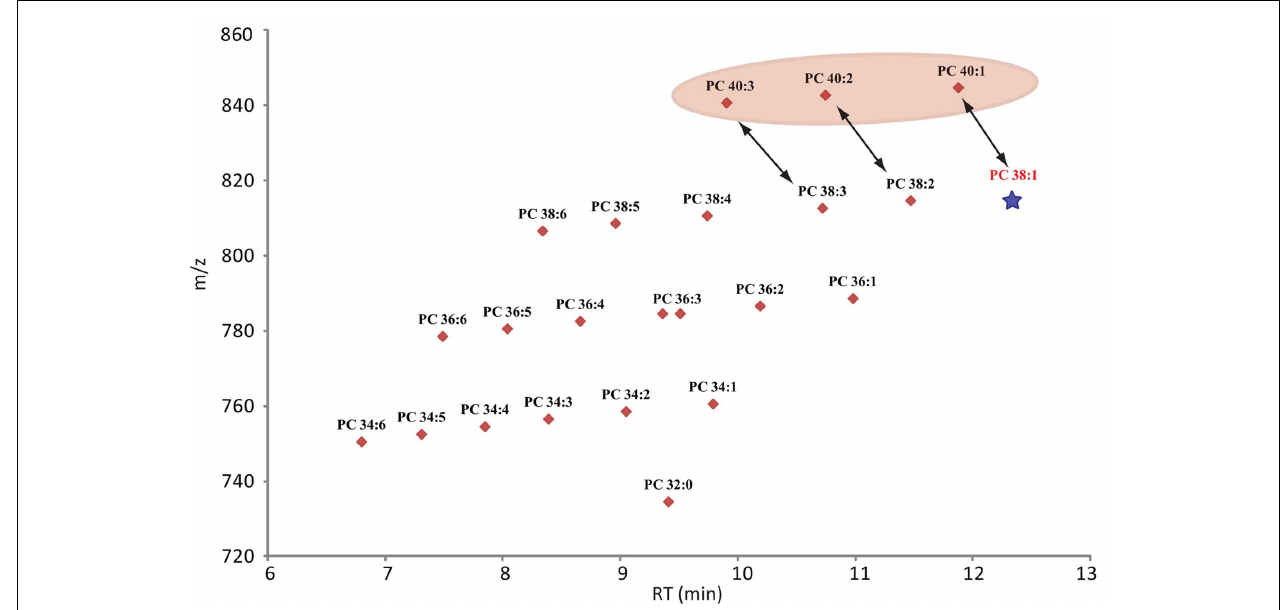
chain length, while the number of double bond should decrease from left to right.The star under PC 38:1 indicates that this lipid was not detected in the analyzed samples, but it would have been expected at this retention time.The PC 40:X series is highlighted since these compounds seem to elute too early and therefore do not match the expected elution pattern given by the whole